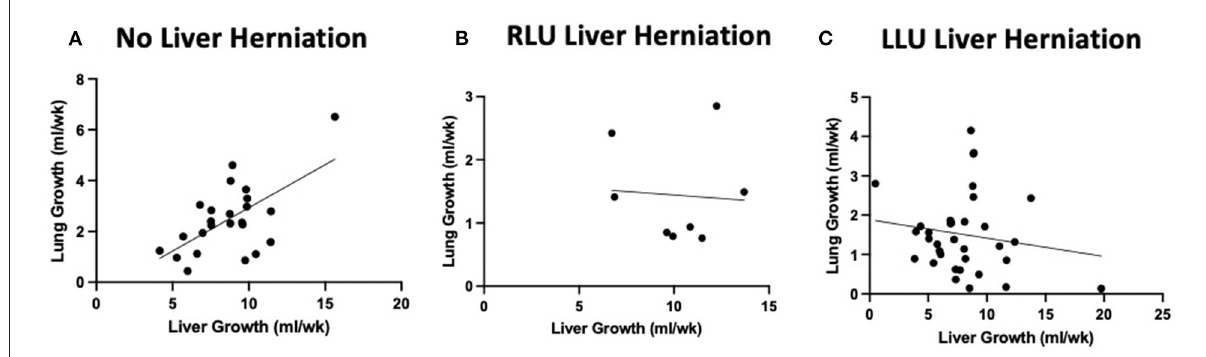
FIGURE3 Liver herniation alters normal positive correlation between liver growth and lung growth. Graphical relationship between total liver growth and total lung growth in cases without liver herniation (LLD) and with liver herniation (RLU and LLU). (A) Positive correlation between total lung growth and total liver growth when the liver is not herniated above the diaphragm ( R 2 = 0.38). (B,C) Loss of positive correlation between lung growth and liver growth when liver is herniated above the diaphragm in both RLU and LLU groups.